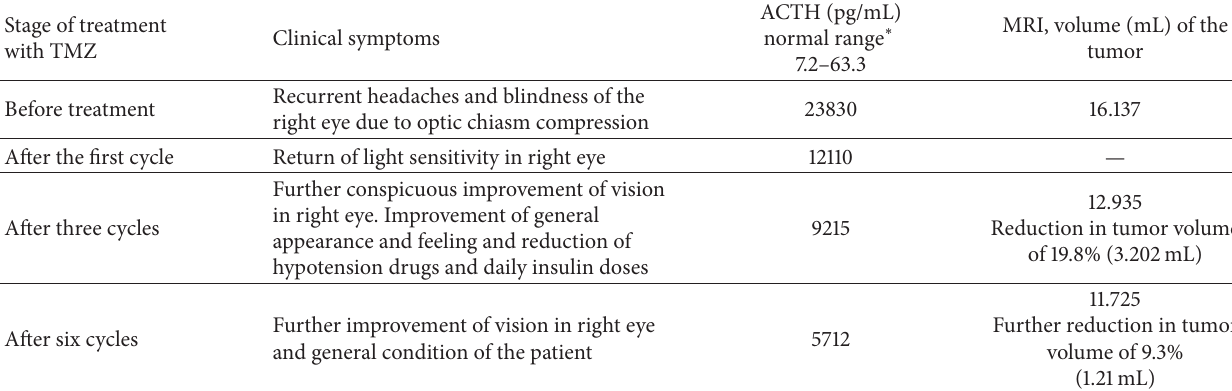
Table 2: The process of TMZ treatment of corticotroph pituitary adenoma in Nelson’s syndrome in our patient. Stage of